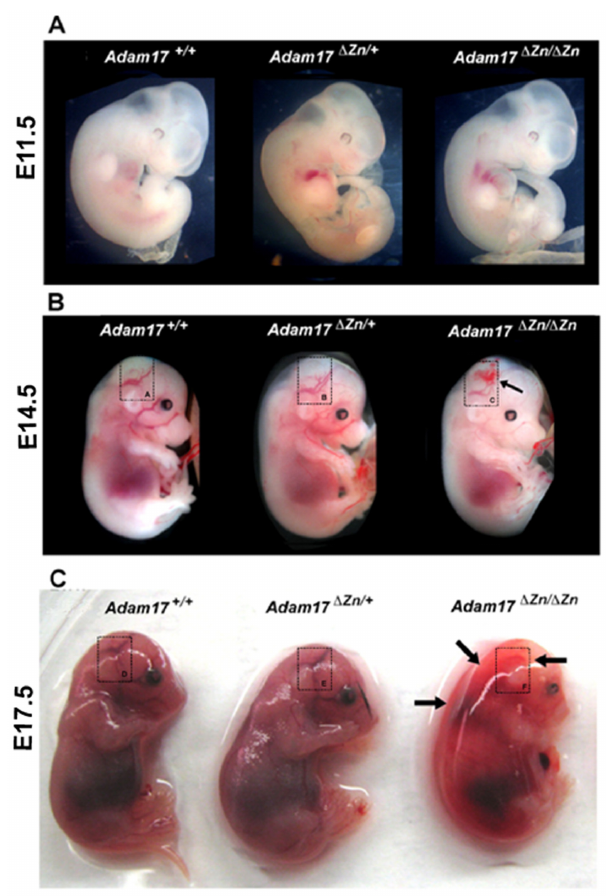
Figure 1. Adam17 D Zn/ D Zn embryos develop internal hemor- rhage. Whole-mount views of Adam17 + / + , Adam17 D Zn/ + and Adam17 D Zn/ D Zn embryos at E11.5 (A), E14.5 (B) and E17.5 (C); embryos were unfixed, unstained. Adam17 D Zn/ D Zn embryos exhibited